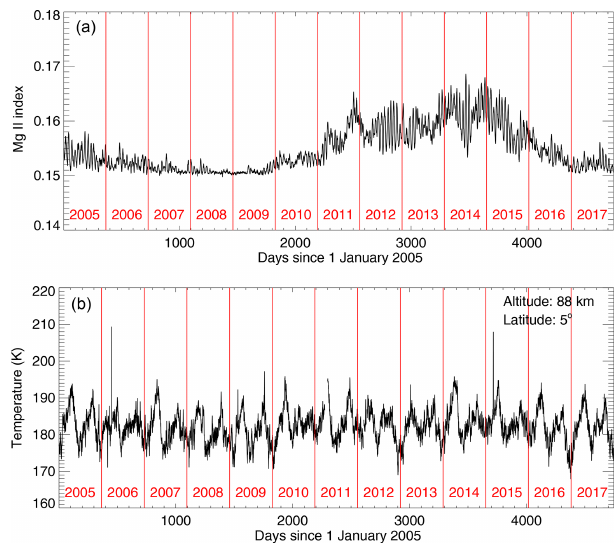
Figure 1. (a) Mg II index data from 2005 to 2017. (b) Time series of zonally and daily averaged temperature for the 5 ◦ N (i.e., 0–10 ◦ N) latitude bin at 88km derived from MLS on Aura. Data gaps